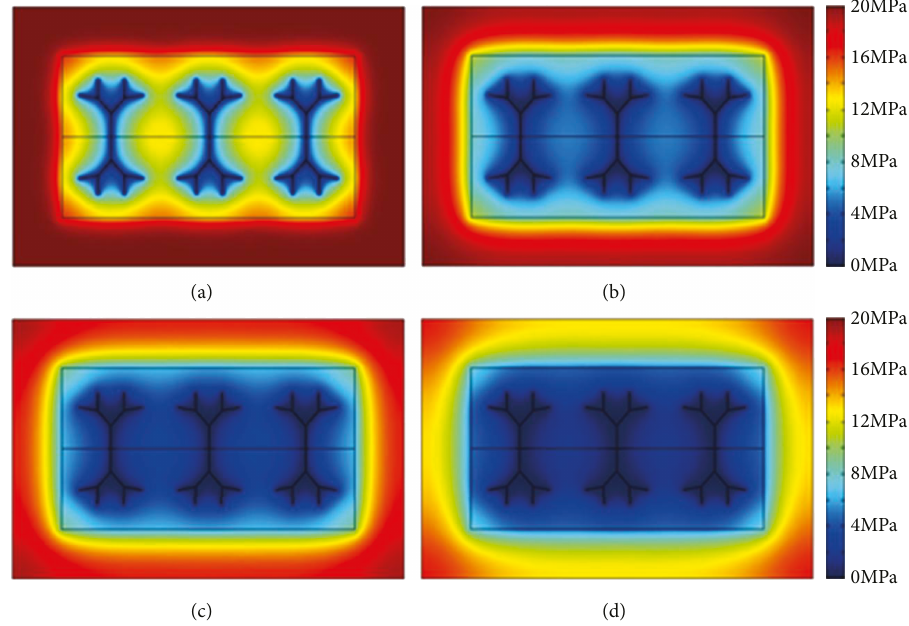
Figure 8: Distribution of formation pressure during the process of thermal stimulation (a) at 1 year, (b) at 5 years, (c) at 10 years, and (d) at 20 years.